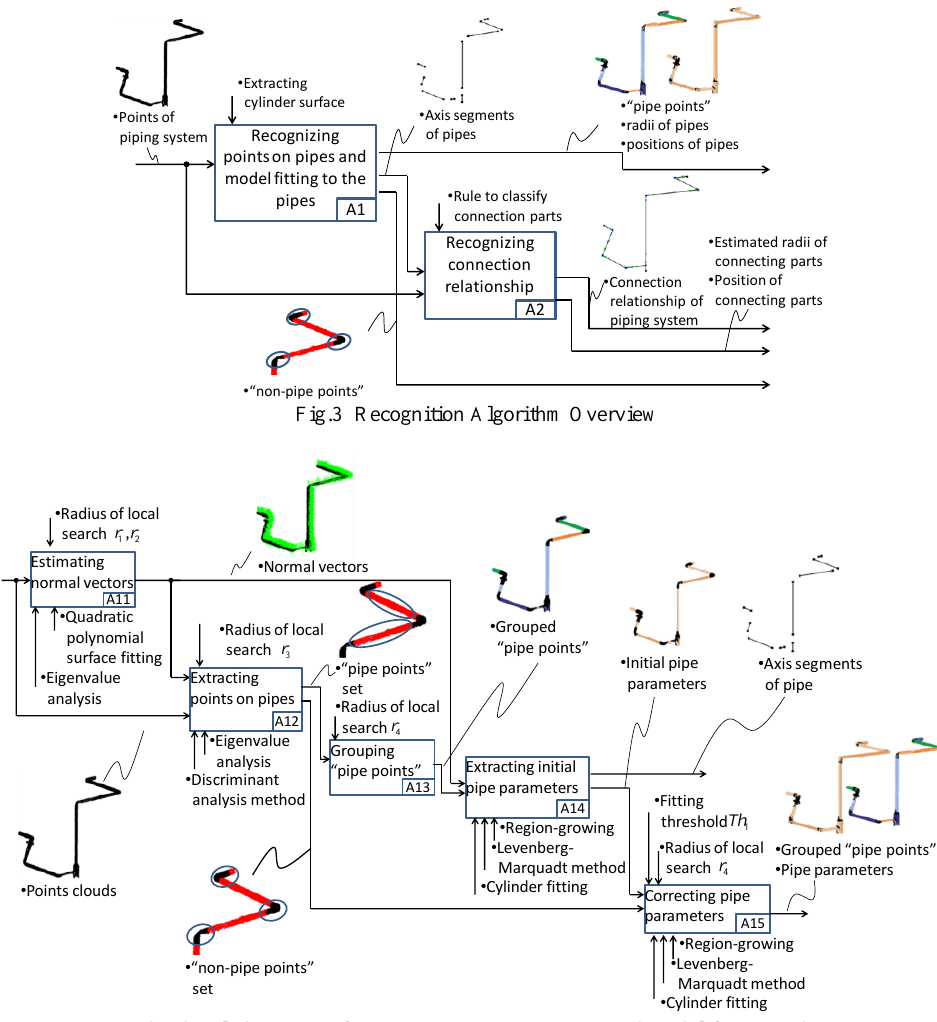
Fig.4 The detailed process of recognizing points on pipes and model fitting to the